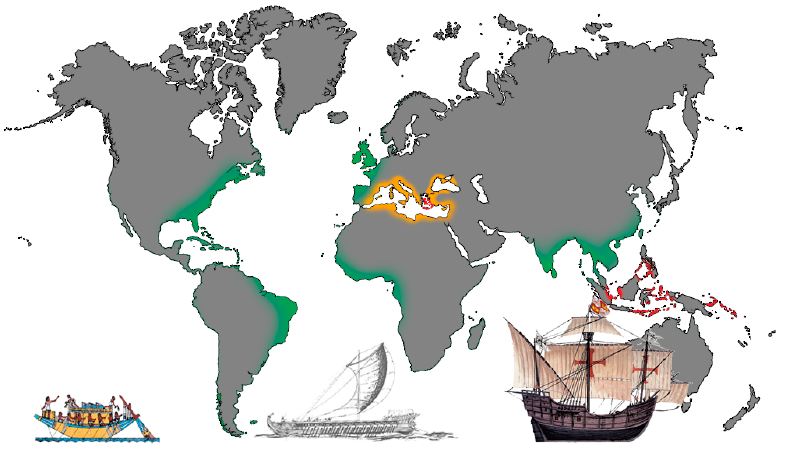
Figure 12. Steps of sailing, connected areas with same color; red, ~10,000 BC rowing boat; yellow, ~1500 BC shipping with tailwind; green, ~1500 AD shipping with caravels.